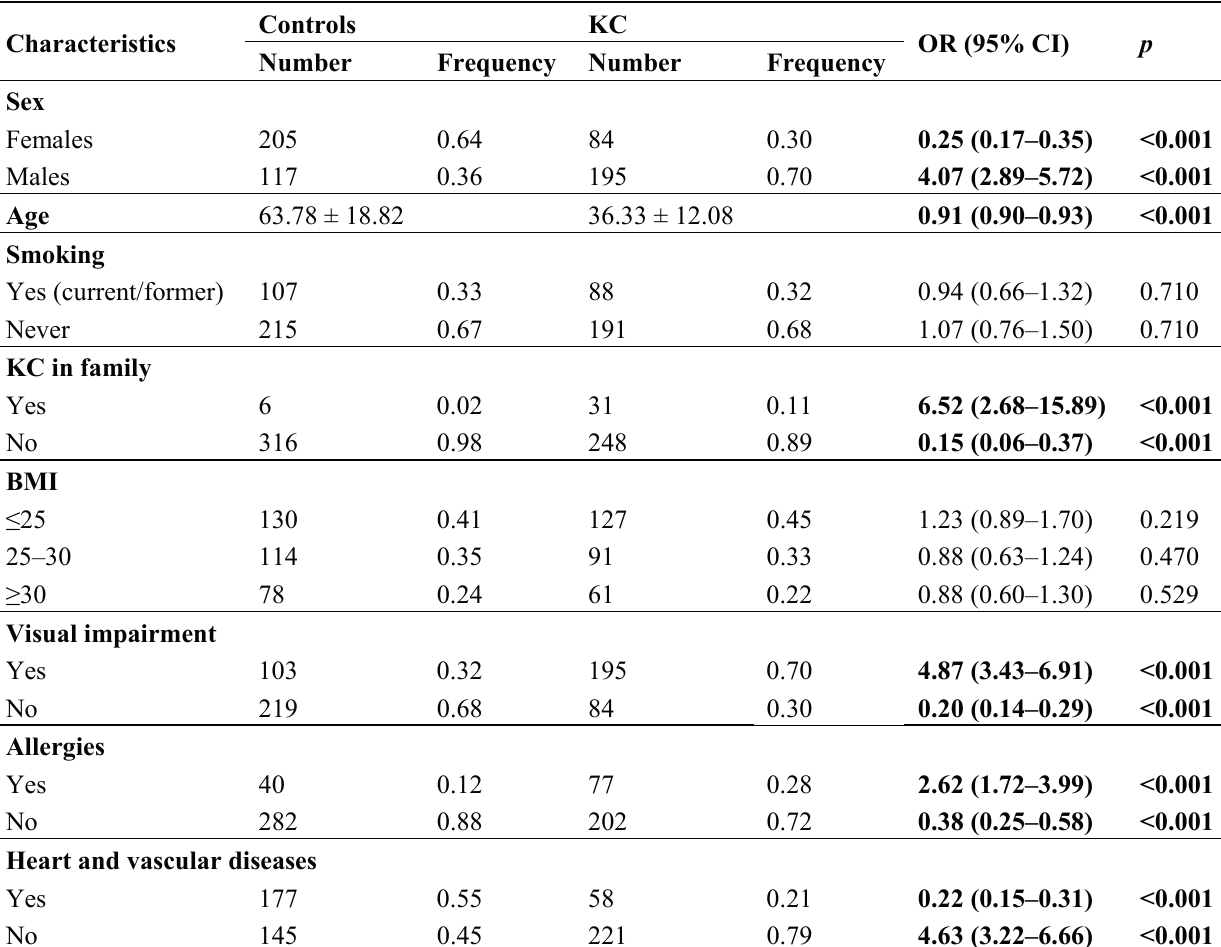
Table 2. Risk of KC associated with age, sex, tobacco smoking, co-occurrence of visual disturbances, body mass index (BMI), heart and vascular diseases, allergies and family history of keratoconus (KC).